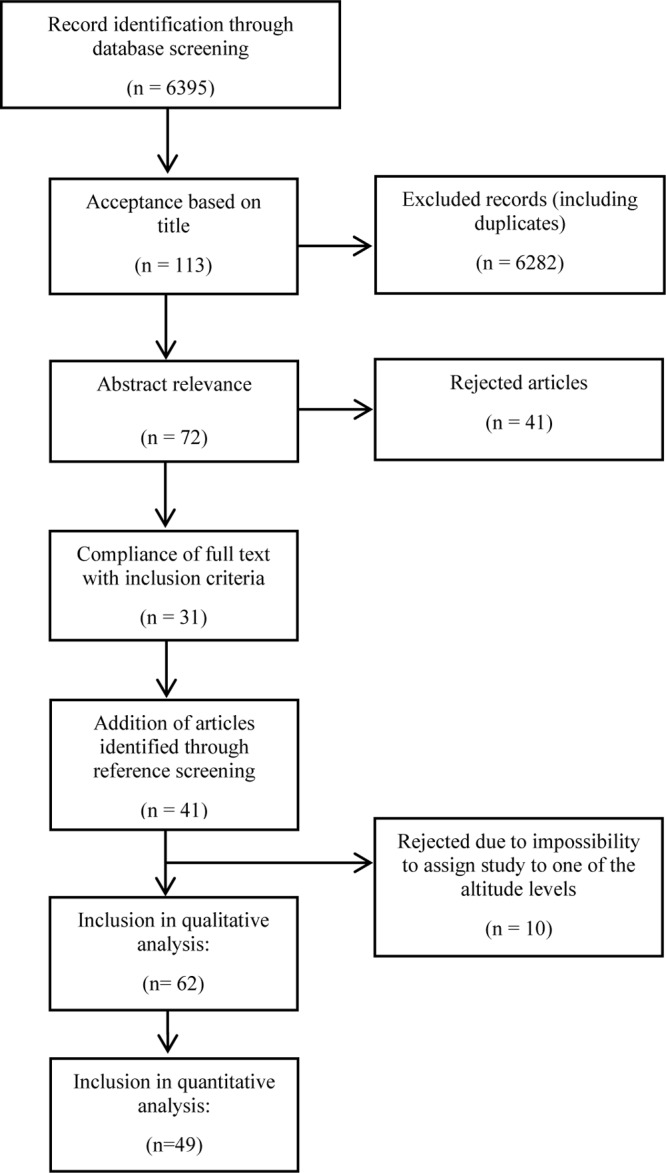
Flow chart representation of literature search.